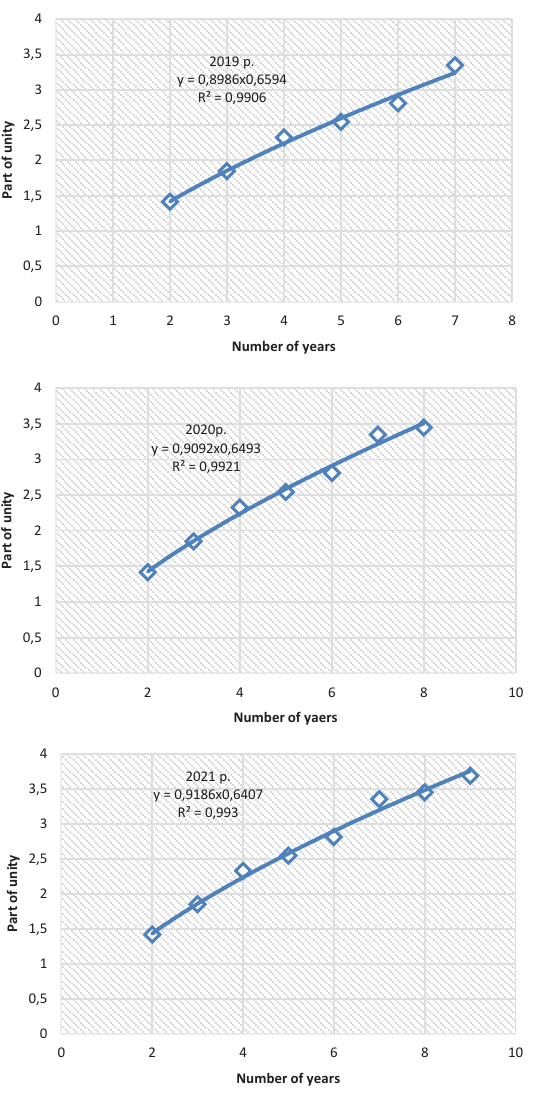
Figure B3. Forecasted levels of investment potential of Ukraine based on the Hurst exponent, taking into account the dynamics of technology growth and without it for